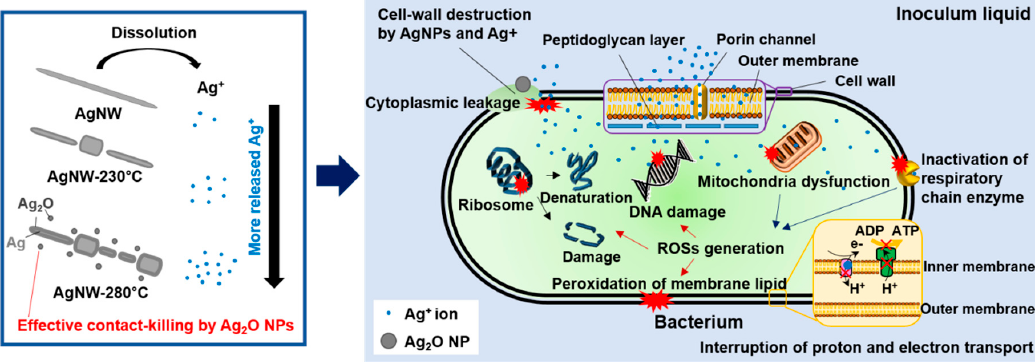
Figure 4. Schematic illustration of the antibacterial mechanisms of AgNW, AgNW-230 °C, and AgNW-280 °C.